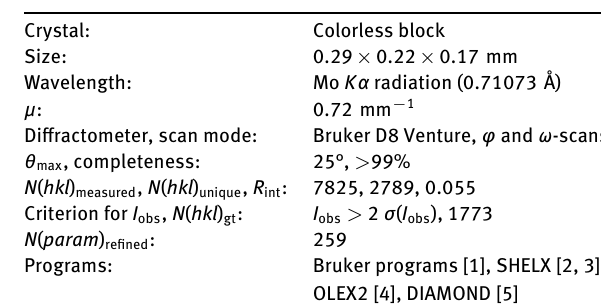
Table 1: Data collection and